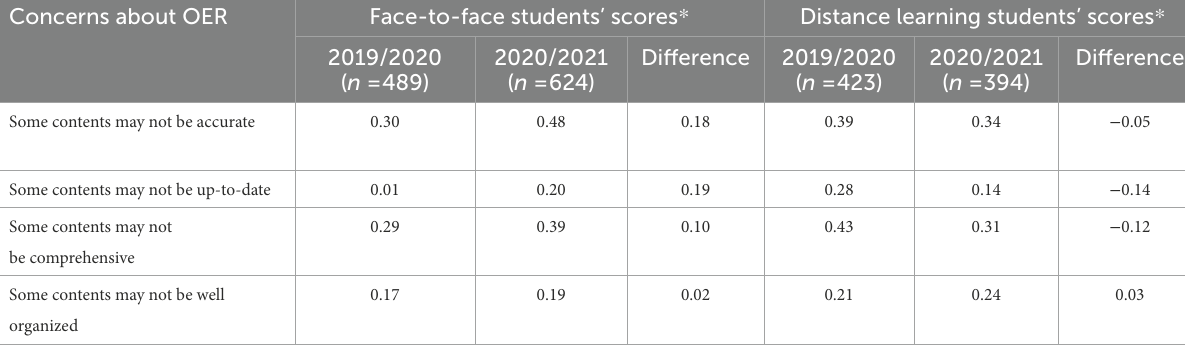
TABLE 6 Concerns about OER for learning purposes.